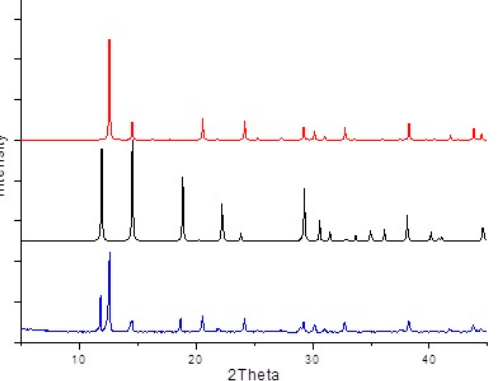
Figure 3. Experimental PXRD pattern of the sample of 1 after 1 h (blue) and calculated patterns of 1 (black) and “dichlorine-free” (Me 3 NH) 2 [SnCl 6 ] (red).